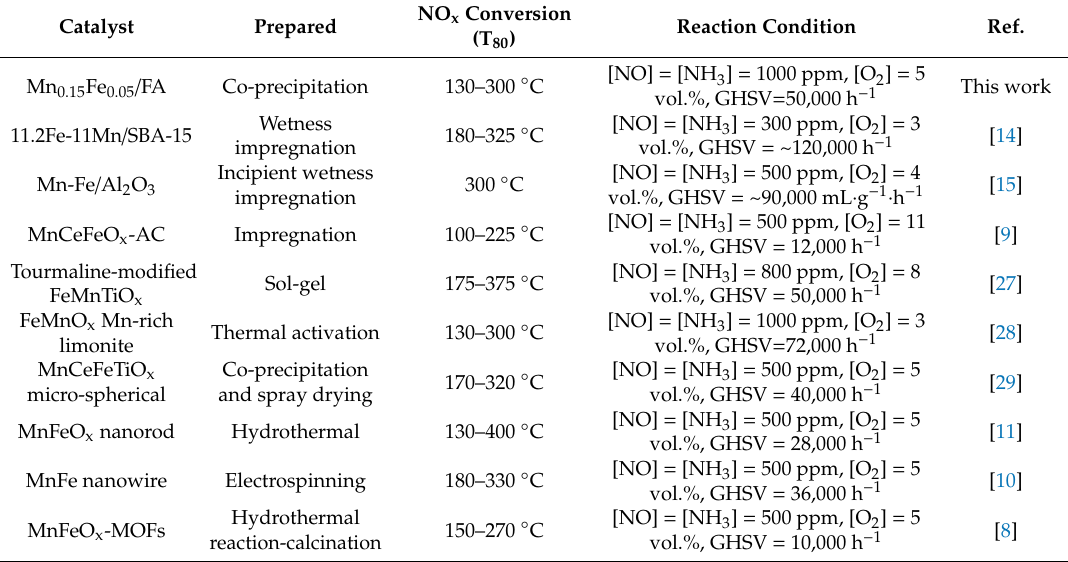
Table 2. Summary of typical MnFeO x oxide catalysts used for the NH 3 -SCR